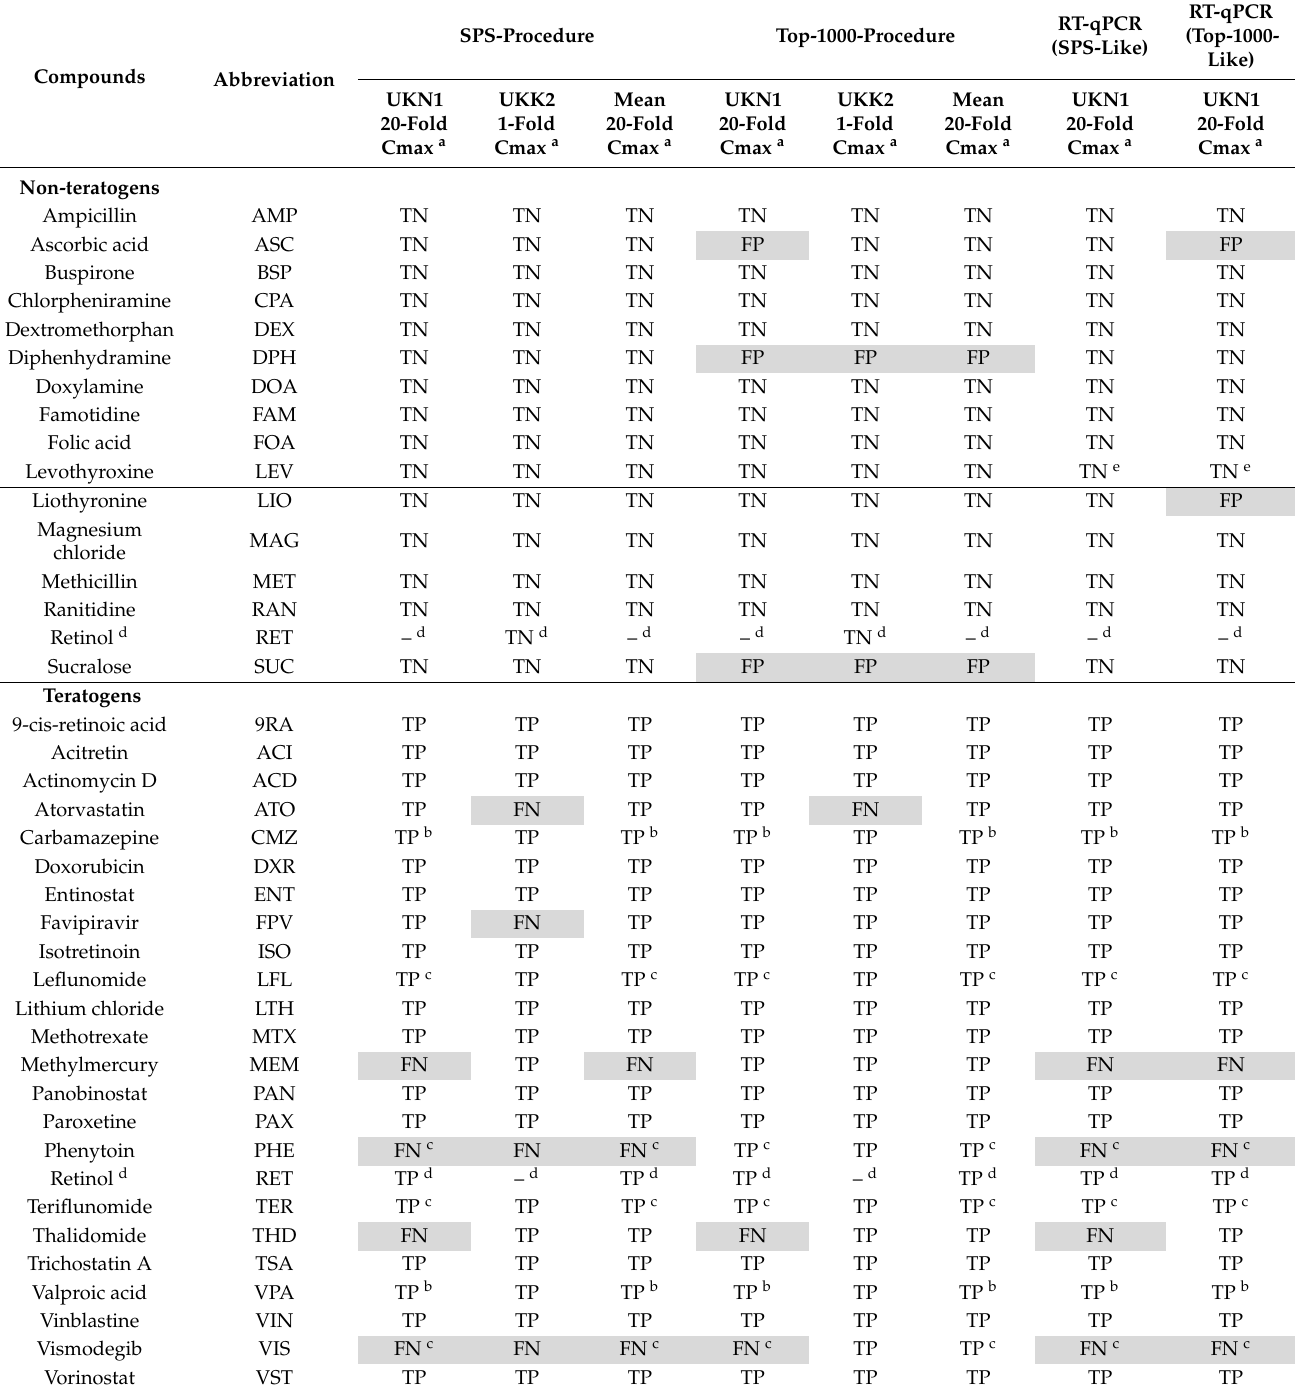
Table 4. Classification of the in vitro results of the test conditions with the highest